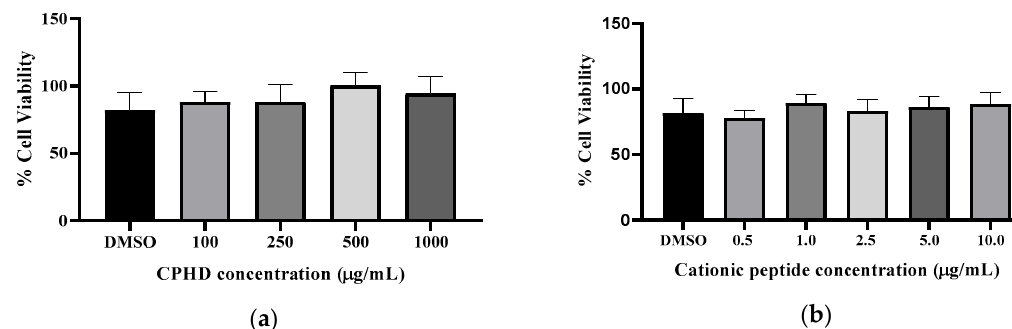
Figure 3. Percentage of macrophage cell viability after exposure to ( a ) CPHD and ( b ) its cationic peptide fraction. CPHD = cricket protein hydrolysates after simulated digestion with gastrointestinal enzymes. Cells were incubated with CPHD (100–1000 µ g / mL), cationic peptide fraction (0.5–10 µ g / mL), or DMSO (0.25%), for 12 h, to evaluate cytotoxicity by MTT assay, with peptides. There was no significant ( p > 0.05) reduction in viability, as compared to the DMSO-treated cells. Data represent the mean ± SD representative of eight (n = 8) independent experiments.